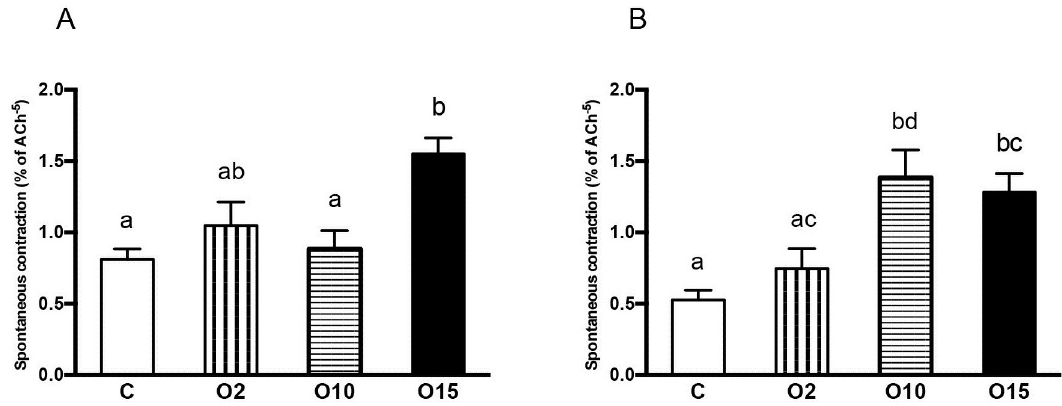
Fig 2. Effect of obestatin on the amplitude [mm] of spontaneous intestinal contractility of the duodenum (A) and middle jejunum (B) in newborn piglets. The amplitude of spontaneous contractions (determined as the percentage of response to acetylcholine chloride (10 − 5 M ACh)) in duodenal and middle jejunum segments from piglets fed milk formula with intra-stomach administrations of obestatin (2 μ g/kg body weight (BW)–O2, 10 μ g/kg BW–O10, 15 μ g/kg BW–O15) or 0.9% NaCl–C, every 8 hours. Results are presented as means ± SEM. a,b,c - indicates statistical differences between